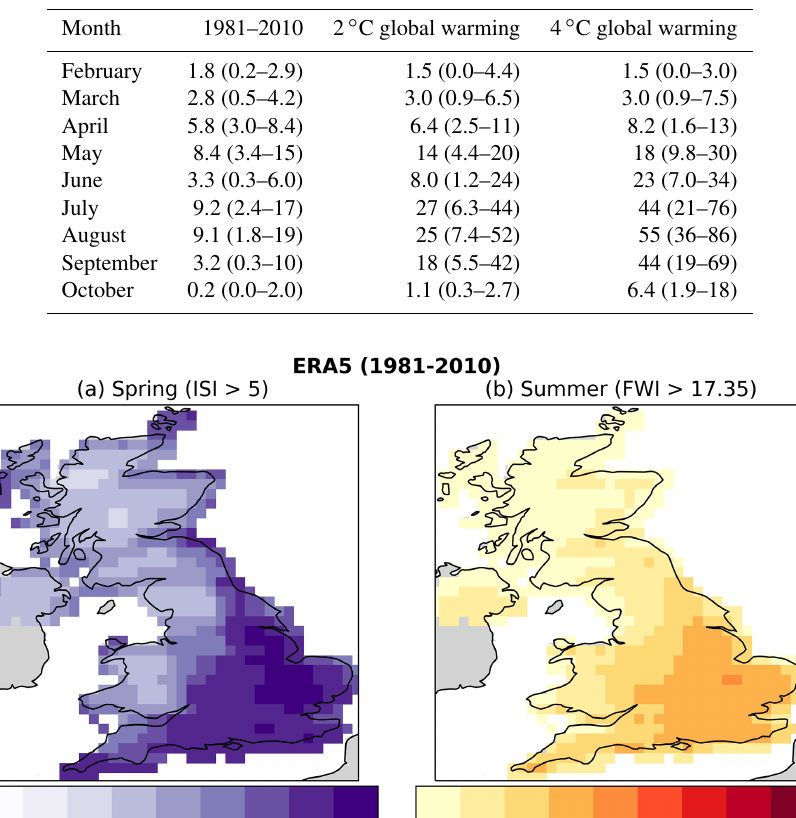
Table 2. Spatial 95th percentile across the UK of the modelled monthly percentage of days with dangerous fire weather (high ISI ( > 5) from February to May, very high FWI ( > 17.35) from June to October). Median and (in brackets) 10th–90th percentile uncertainty range from the 12 ensemble members. Values are quoted to two significant figures.